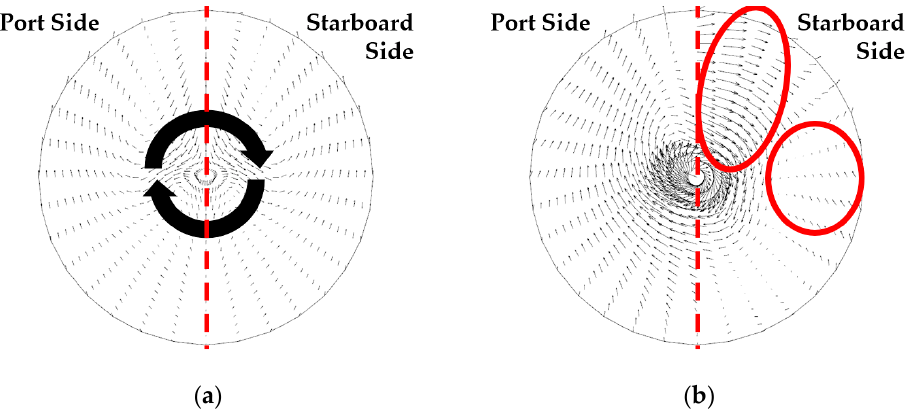
Figure 8. Tangential component of wake distribution ( a ) without the propeller; ( b ) with the propel ‐ ler.